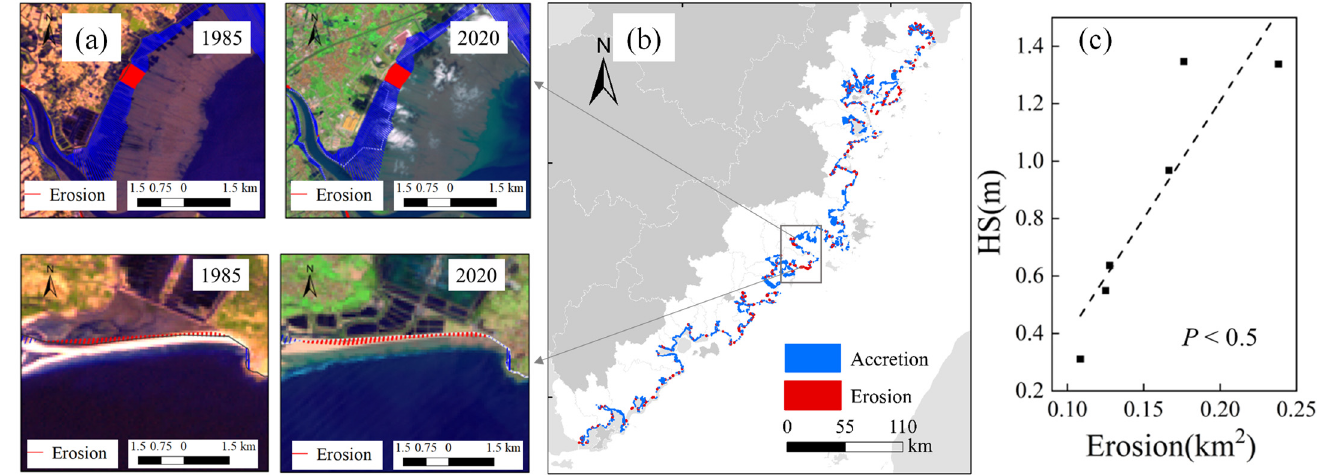
Figure 10. ( a ) Erosion and accretion of coastlines from 1985–2020; ( b ) The overview of Erosion of reclamation in continental coastlines of Fujian for 35years. ( c ) The relationship between erosion areas and local significant wave height.